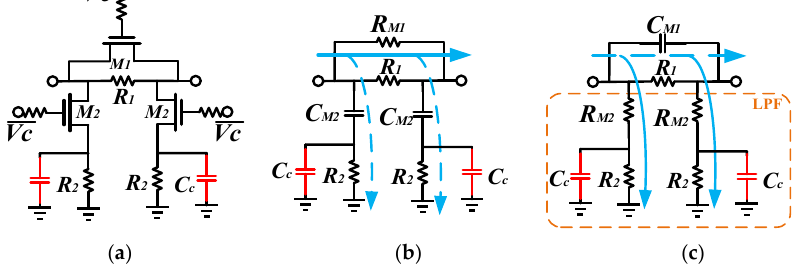
Figure 9. ( a ) The schematic of the switched π -type attenuation cell with shunt capacitors. ( b ) Reference state. ( c ) Attenuation state.